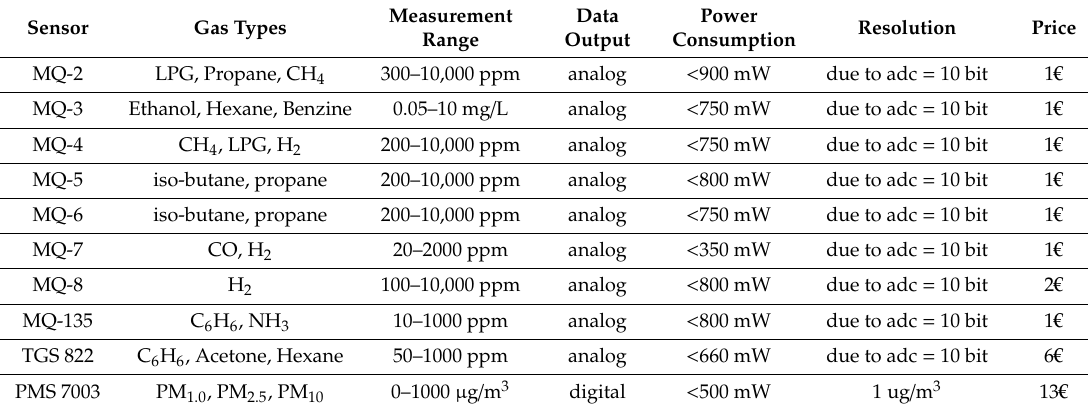
Table 1. Low-cost sensors parameters used for the multisensory array design.